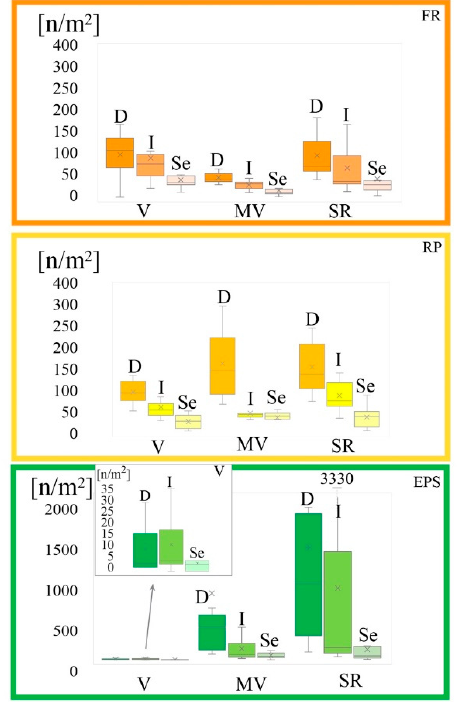
Figure 4. Distribution of FR (orange box on the top), RP (yellow box in the middle) and EPS densities (green box below), expressed in number of items for square meter (n / m 2 ), per site (SR, MV, V,) according to the beach zonal analysis (Dune: D, Intermediate: I, Sea: Se). The enlarged box shows in detail the situation of Viareggio for EPS fraction.